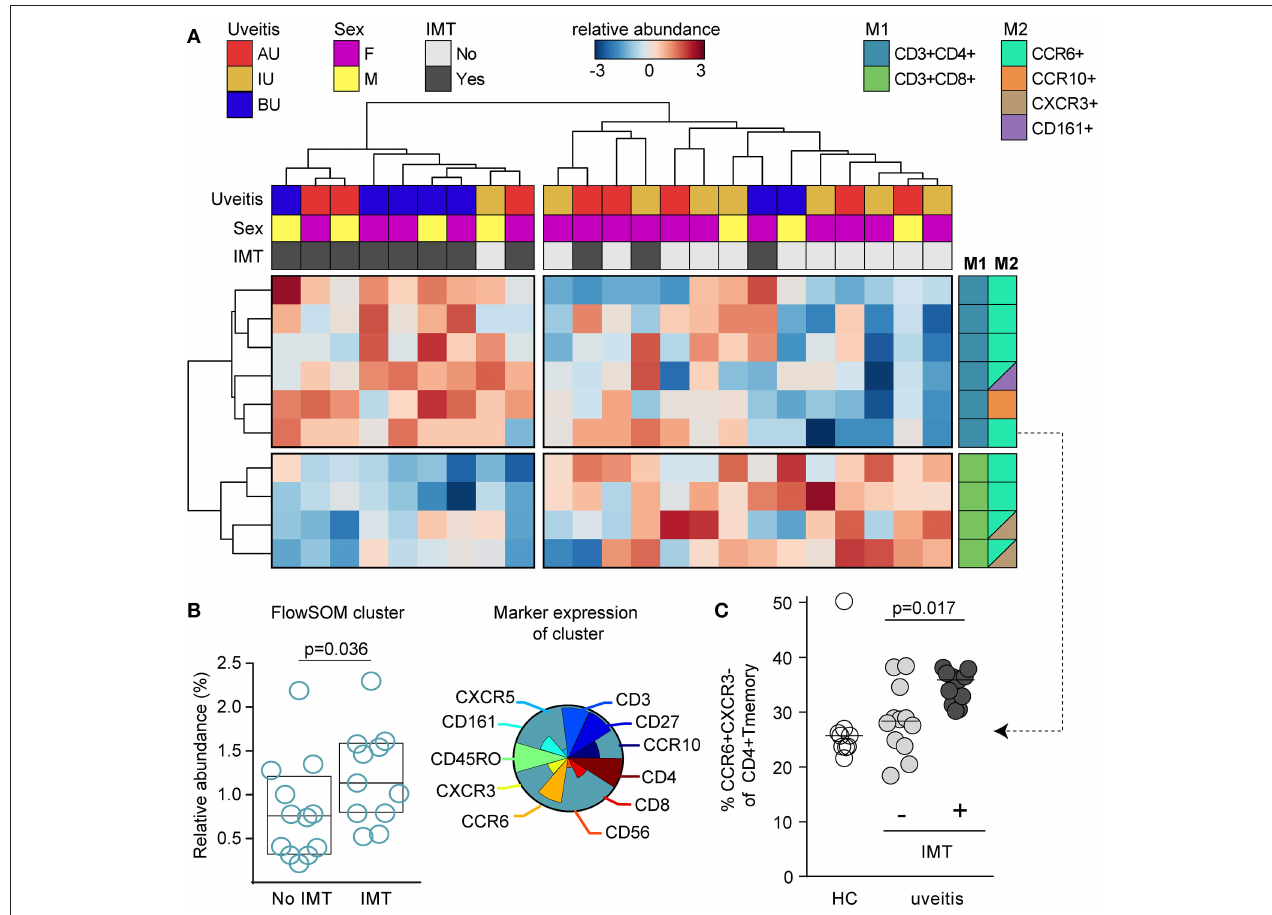
FIGURE 8 | CCR6 + T cells are increased in patients that need systemic immunomodulatory treatment. (A) Unsupervised hierarchical clustering of the top 10T cell subsets in 23 patients with complete data distinguishes two clusters of patients that are characterized by altered proportion of CD4 + and CD8 + T cell populations and differential requirement of IMT during follow-up. Heatmap colors represent the relative difference in proportion from relatively low (in blue) to high (in red) for each manually gated population. Data were normalized using quantum normalization and log transformation. Data are scaled using Auto scaling. The sample meta-data and the leukocyte subsets contributing to these clusters are indicated. M1, first color marker to define CD4 or CD8 expression in T cell populations; M2, additional color marker to define chemokine receptor or CD161 expression for each T cell population. (B) FlowSOM analysis identified a cluster from meta-cluster B with significantly higher abundance in patients that required IMT during follow-up before commencing therapy. This IMT associated FlowSOM cluster has a phenotype consistent with Th17 cells (CD3 + CD4 + CD45RO + CXCR3-CCR6 + ). The pie chart indicates the relative expression for each of the different surface markers that